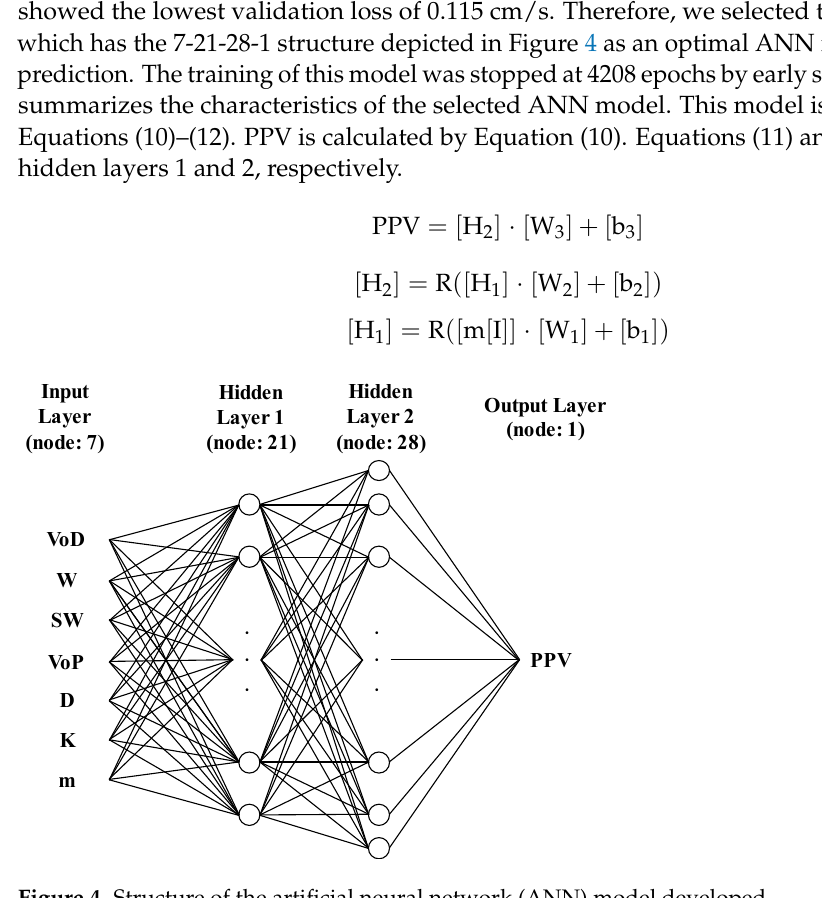
Figure 4. Structure of the artificial neural network (ANN) model developed. Table 5. Characteristics of the ANN model.